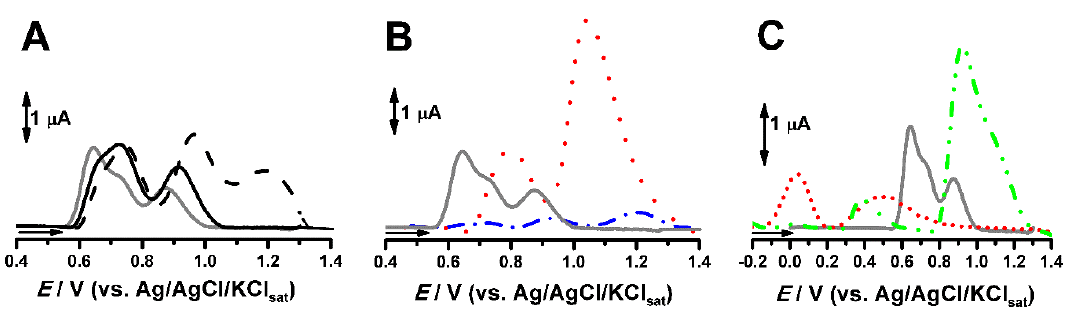
Figure 3. Solid-state differential pulse voltammograms of 1% CRV in: CP control (grey line of figures